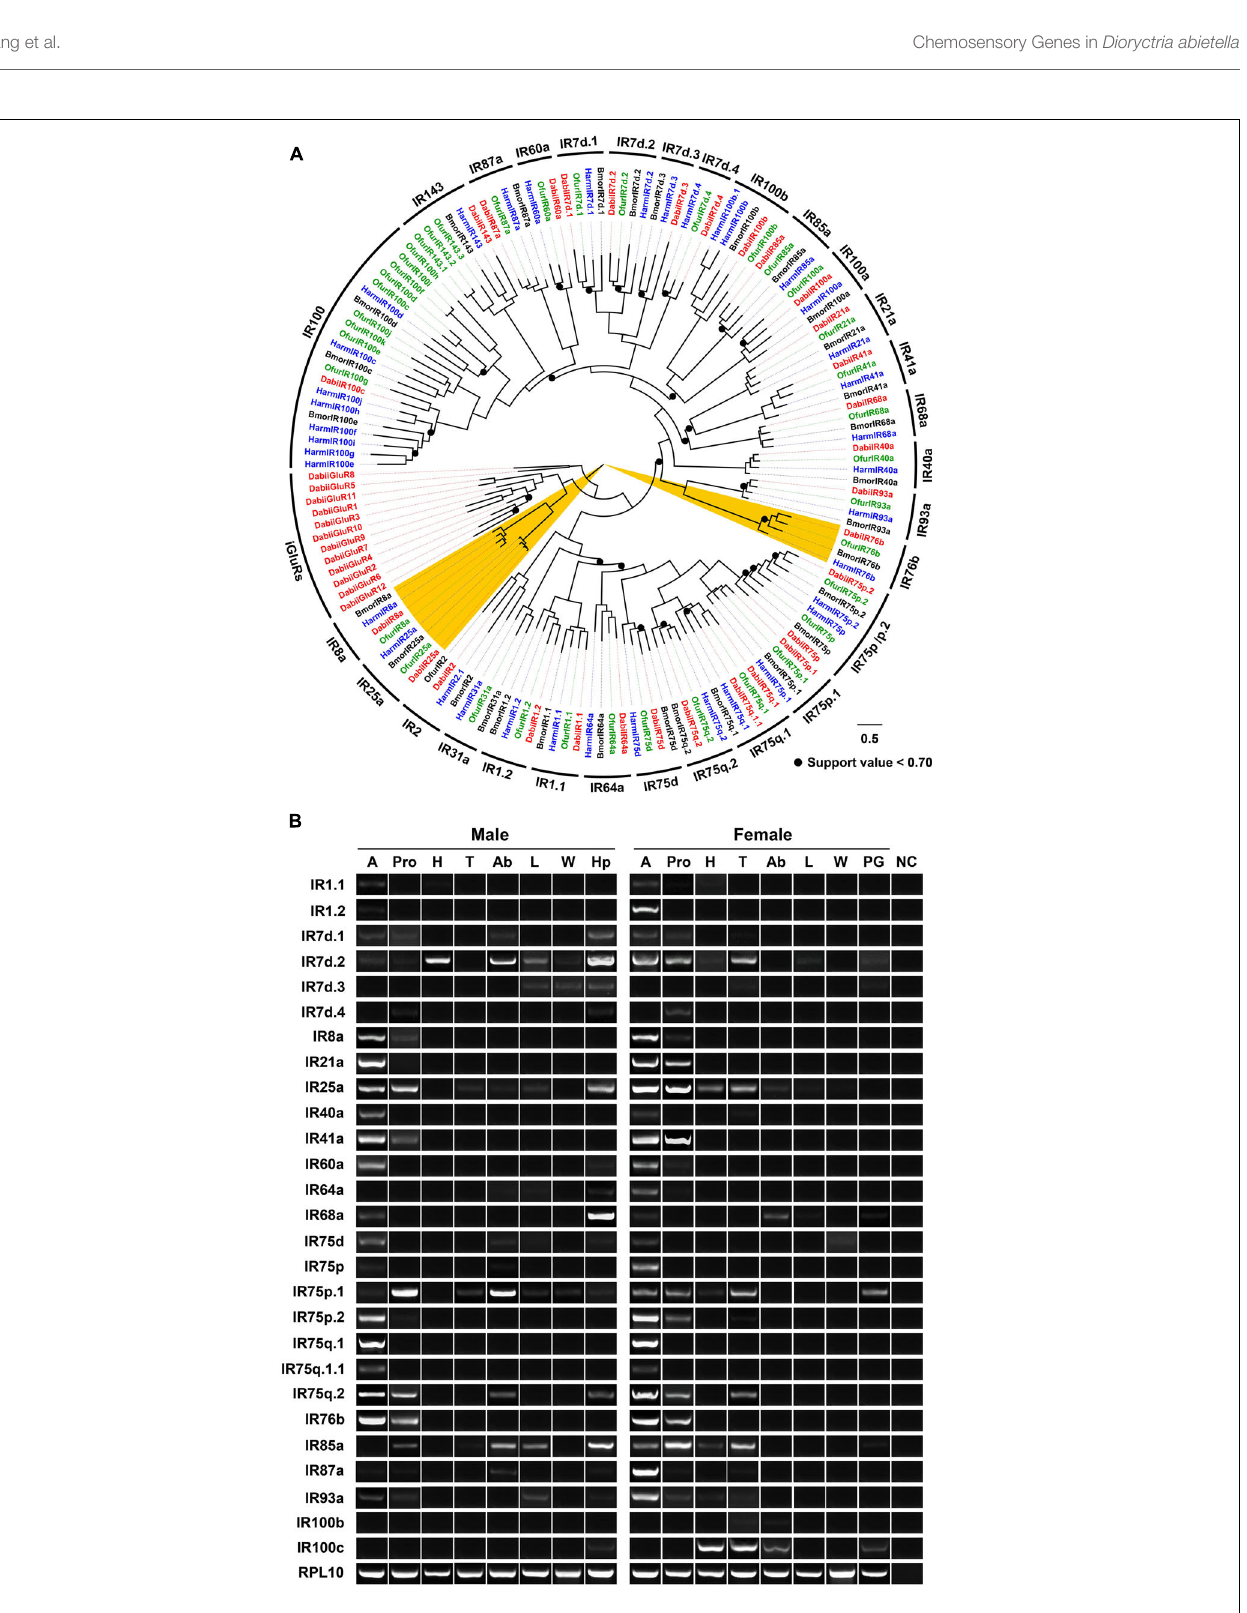
FIGURE 7 | The candidate IR gene family in D. abietella . (A) The phylogeny of IRs from B. mori (Bmor, black), D. abietella (Dabi, red), H. armigera (Harm, blue), and O. furnacalis (Ofur, green). According to sequence homology of IRs, members of the IR gene family were grouped into various orthologous clades, with three conserved IR coreceptors (IR8a, IR25a, and IR76b). The tree was rooted with D. abietella iGluRs. (B) Expression profiles of candidate DabiIRs in different tissues of both sexes from D. abietella . The quality and quantity of cDNA templates were measured by a reference gene, DabiRPL10 . NC, negative control using sterile water as the template. The full names of tissues are listed in Table 1